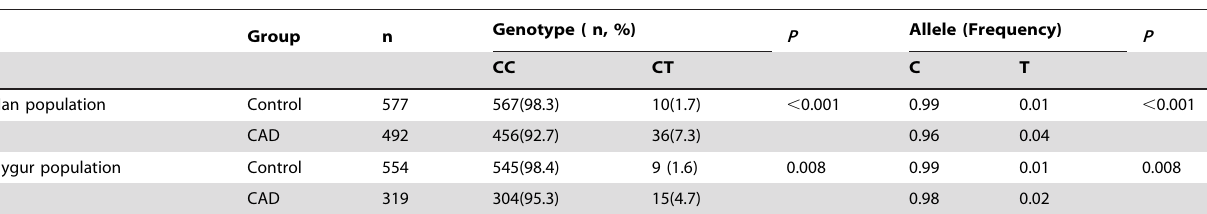
Table 2. Distribution of genotypes and alleles of C5L2 gene.